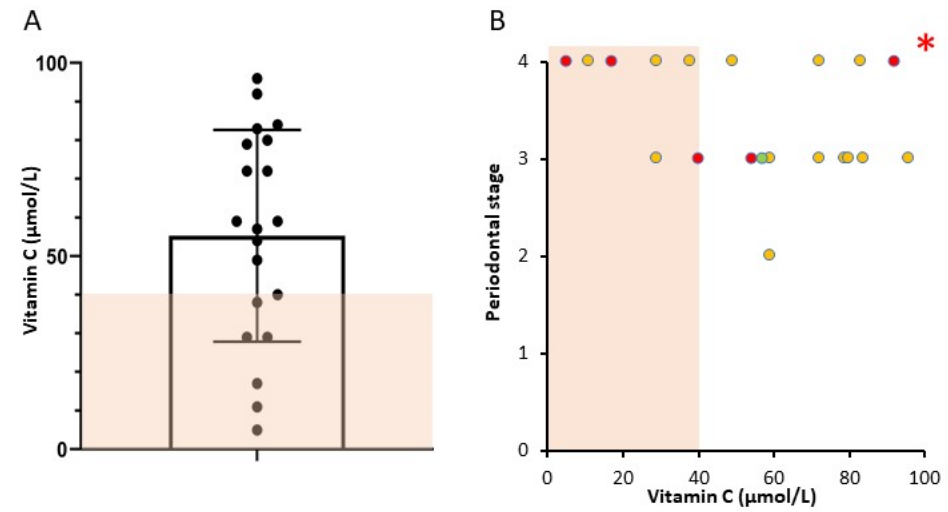
Figure 2. Serum vitamin C and periodontal stage. ( A ) Individual vitamin C results for each patient. The shaded area indicates results below the assay normal range. One patient returned a serum vitamin C of 40 μmol/L (normal 40 -100 μmol/L) and was classified as normal. ( B ) Periodontal stage was evaluated by the treating dentist (RR) prior to blood collection for vitamin C. Symbol fill colour indicates grade of periodontal disease (A = green, B = yellow, C = red). * = p =